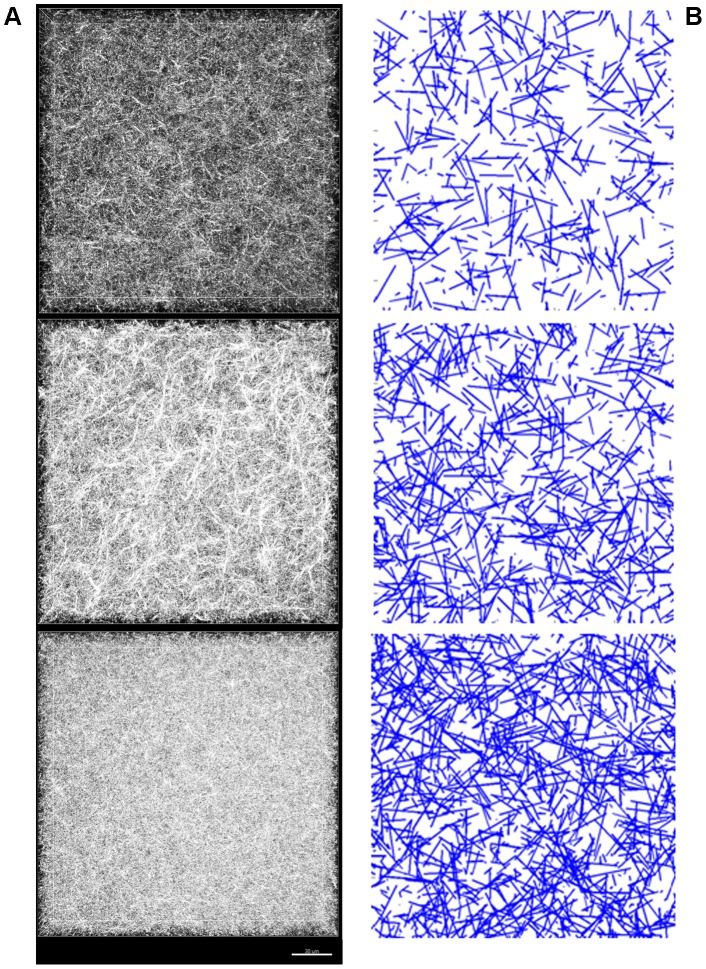
Comparison of experimental and simulated matrices.(A) CRM images of 2, 3, and 4 mg/mL collagen gels, from top to bottom (originally shown in [17]); and (B) cross-sections of simulated matrices containing 1200, 2000, and 3000 fibers per lattice, from top to bottom. The CRM images show a view of a whole stack of acquired images from above, while the images from the model depict cross-sections of the matrices, which may give the appearance of there being a significant difference in fiber density between the two.